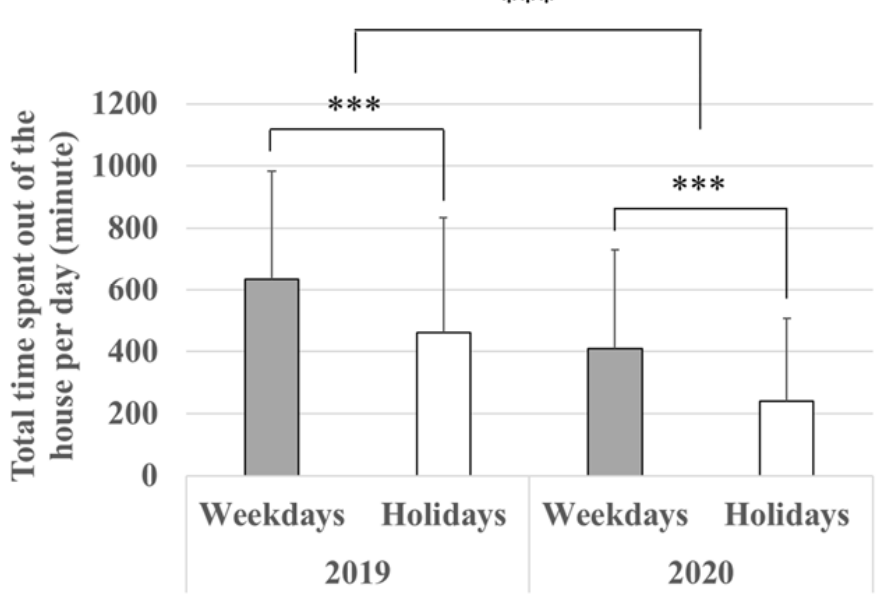
Figure 4. Total time spent out of the house per day (mean ± S.D). *** designates p < 0.001. n (2019) = 38,011 and n (2020) = 42,197.